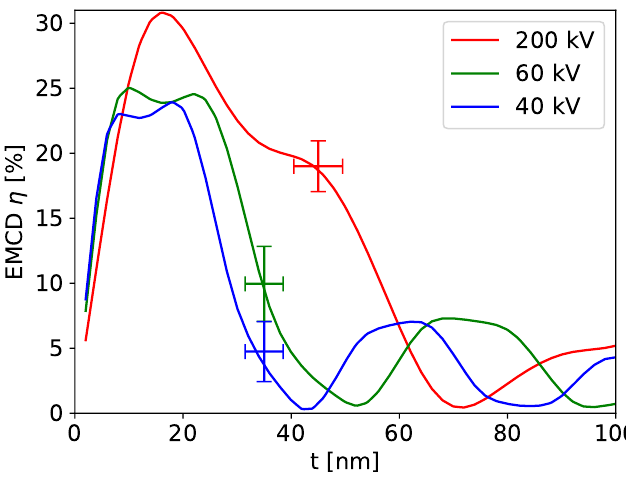
Figure 3. EMCD spectra for different acceleration voltages (as indicated) after background subtrac- tion and post-edge normalization using the Fe L-edge in Magnetite tilted to a ( 400 ) systematic row condition. The sample-thickness was determined to be t ≈ 35nm for the 40kV and 60kV measurement positions and t ≈ 45nm for the 200kV measurement position.